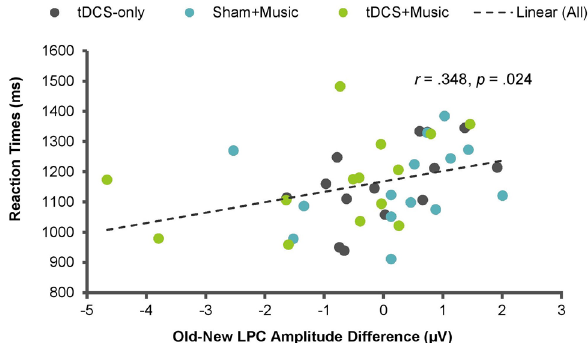
Figure 5. Scatter plot visualizing the correlation between the old-new Late Positive Complex (LPC) amplitude difference and RTs in the R8 repetition lag of the auditory word recognition